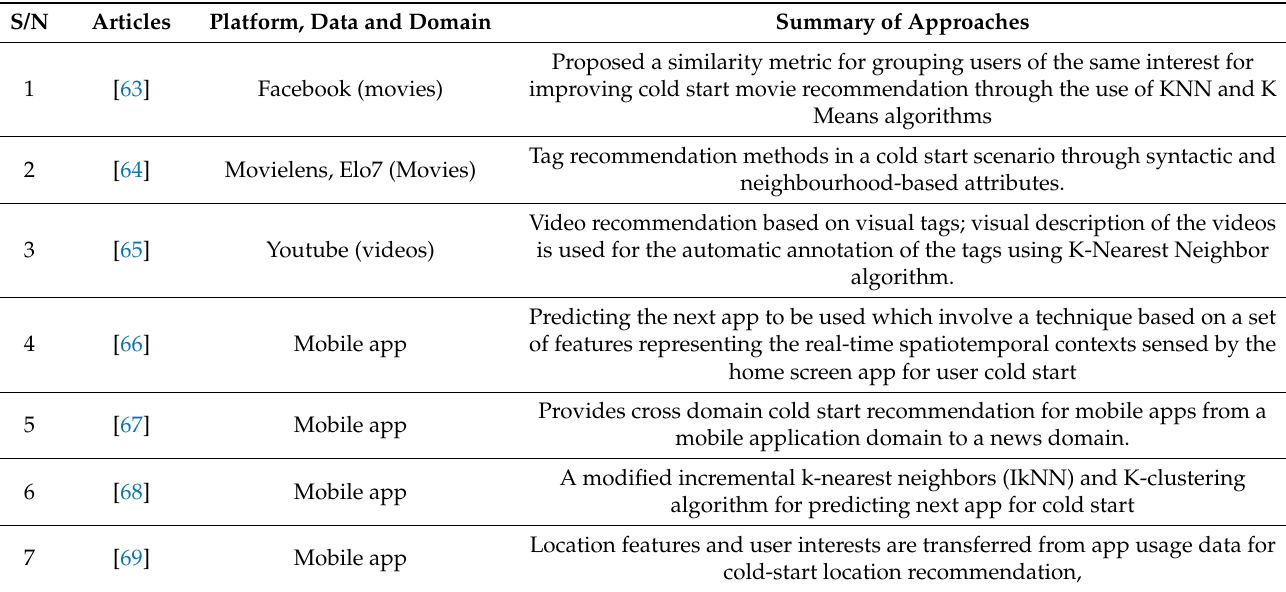
Table 3. Adapting memory-based